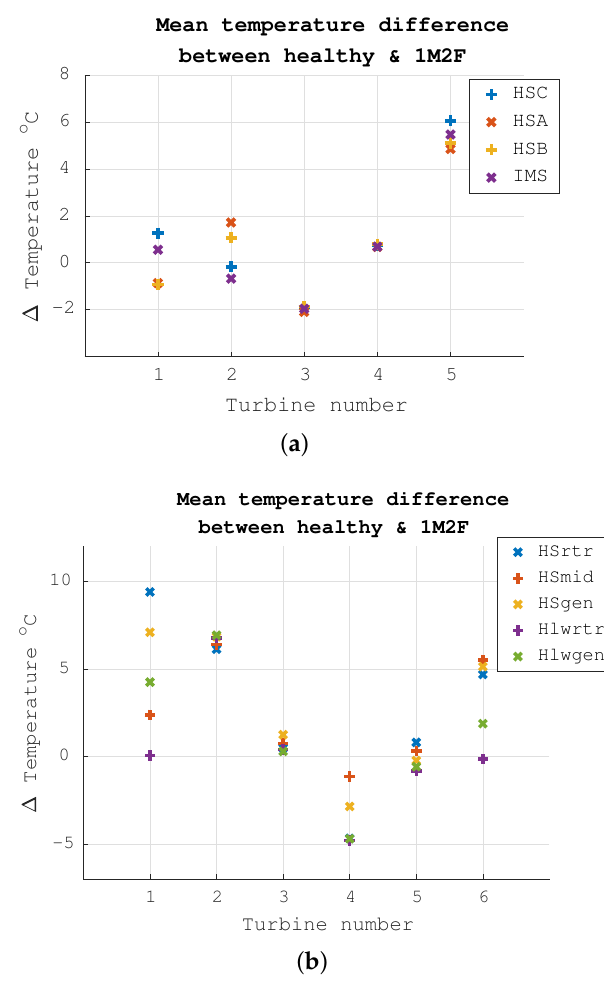
Figure 2. Mean temperature measurements from sensors in dataset 1 ( a ) and dataset 2 ( b